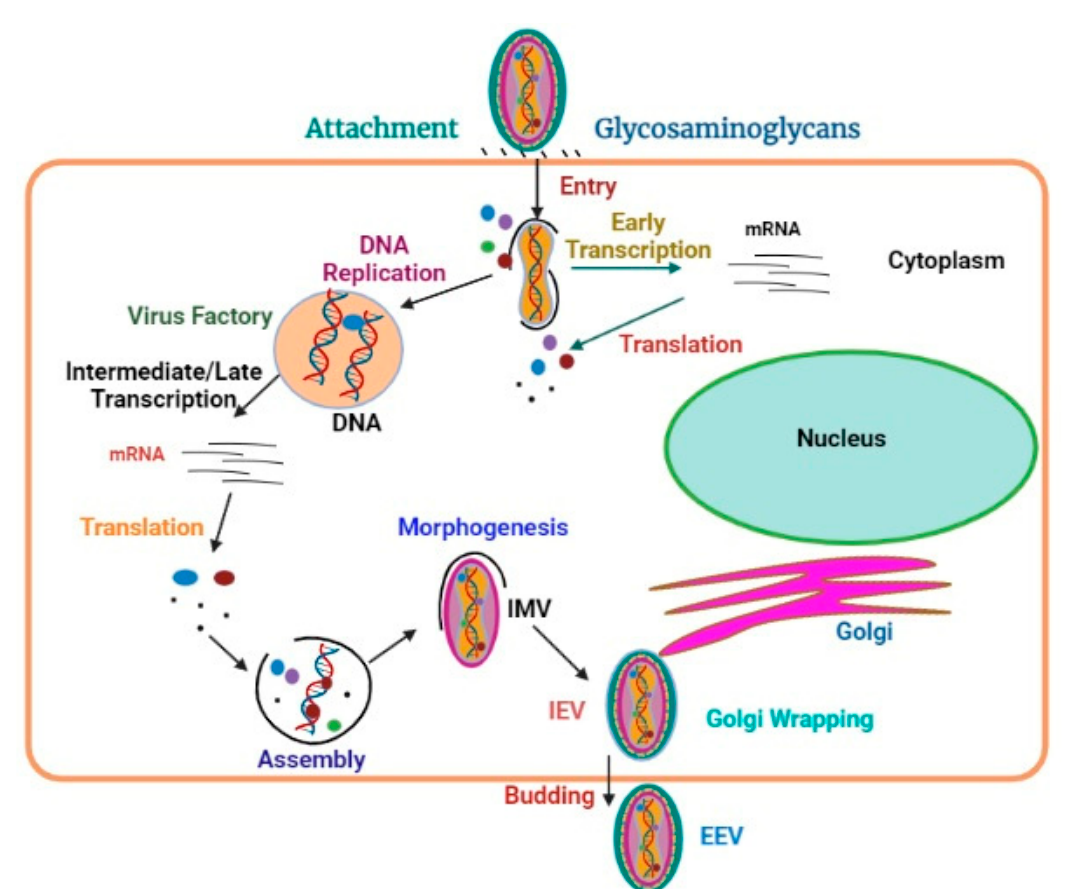
Figure 2. Replication and transmission of monkeypox virus.